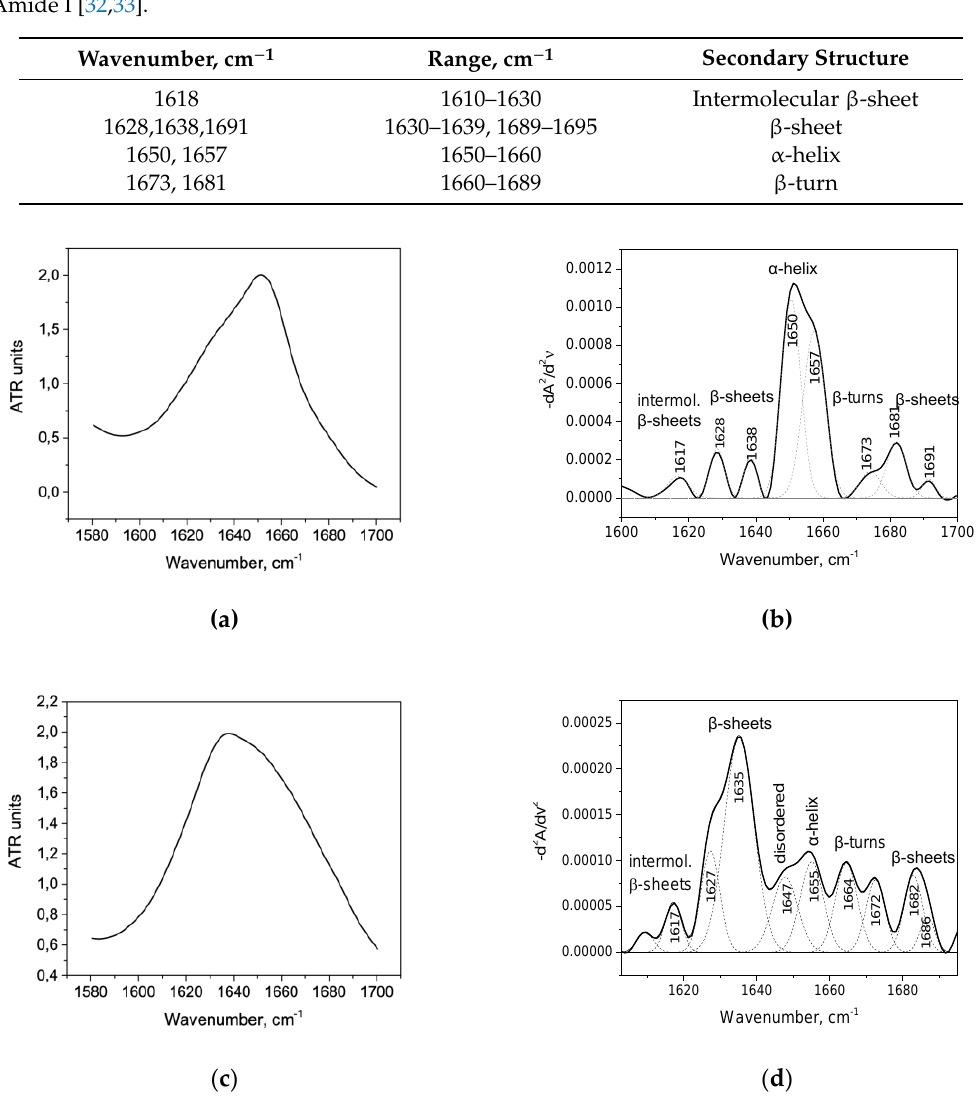
Table 2. The correlation between protein secondary structure and the second derivative of Amide I [32,33].